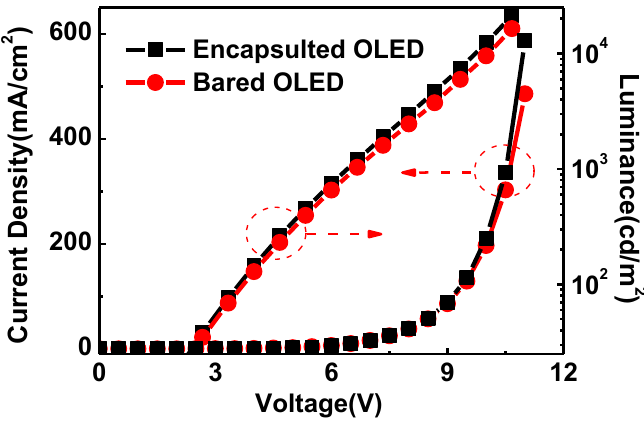
Figure 6. The comparison of I-V characteristics between encapsulated organic light emitting devices (OLED) and bear